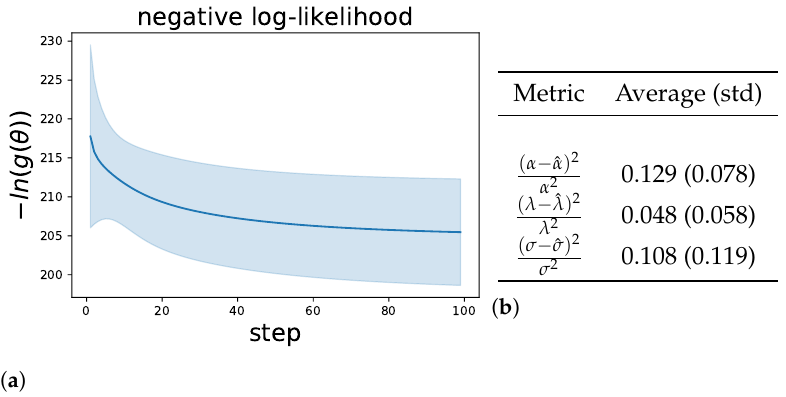
Figure 1. ( a ) Average values, with standard deviation, over 2000 simulations of the negative log- likelihood along the steps of the Riemann EM. The Riemann EM increases the likelihood. ( b ) Average and standard deviation of the relative parameter reconstruction errors at the end of the Riemann EM.